Question: Looking at the figure, what chart type is it?
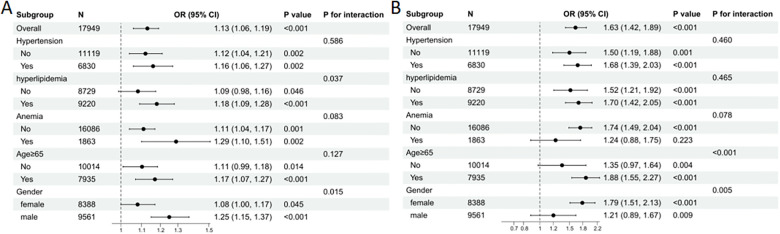
Answer: forest